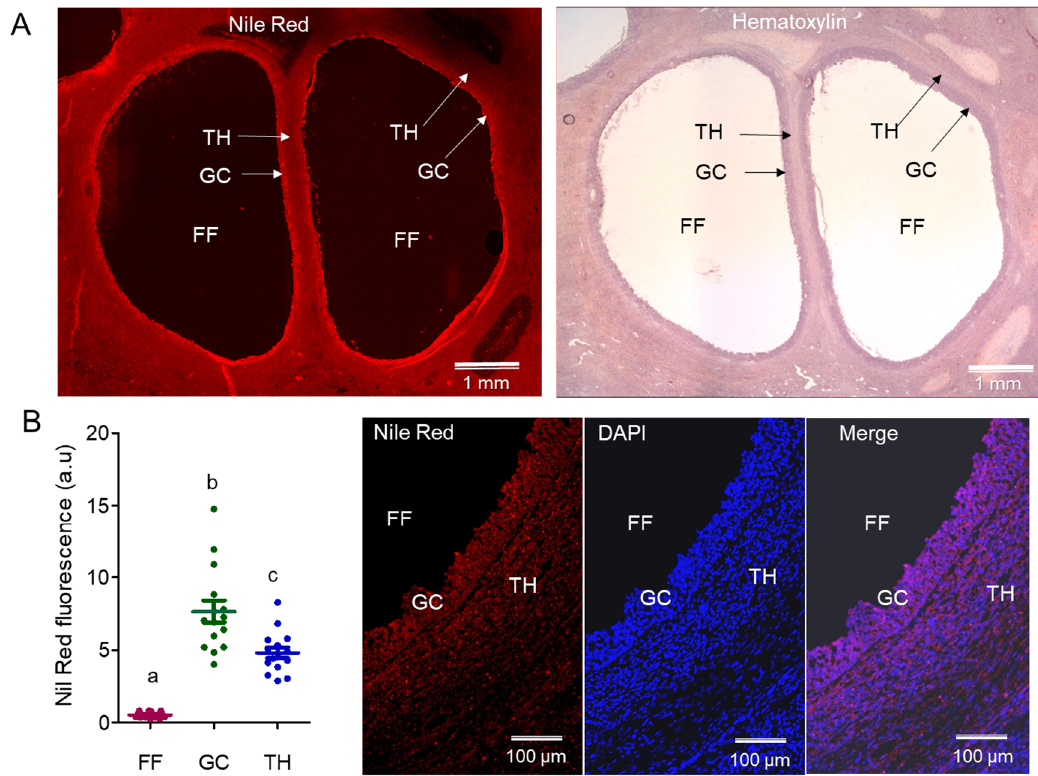
Figure 1. Quantification of lipids in bovine follicular compartments by Nile red fluorescence (NRF). ( A ) Nile red staining (left picture) and hematoxylin coloration of ovarian section (right picture). ( B ) Scatter plot represents Nile red fluorescence quantification in follicular fluid (FF), granulosa cells (GC), and theca cells (TH) in 15 follicles with an average size of 5.5 mm. Different letters mean significant difference at p < 0.05, (Kruskal–Wallis test and Dunn’s multiple comparison test). Representative region of the follicle stained with Nile Red (lipids) and DAPI (DNA) is shown.